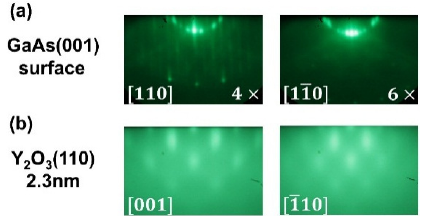
Figure 1. In ‐ situ RHEED patterns of ( a ) freshly MBE grown GaAs(001) ‐ 4 × 6; and ( b ) subsequent growth of ALD ‐ Y 2 O 3 (110) films 2.3 nm. The zone axes for the growth on GaAs(001) from the left to the right are GaAs[110], [1 1 0], and ALD ‐ Y 2 O 3 [001] and [ 1 10], respectively.